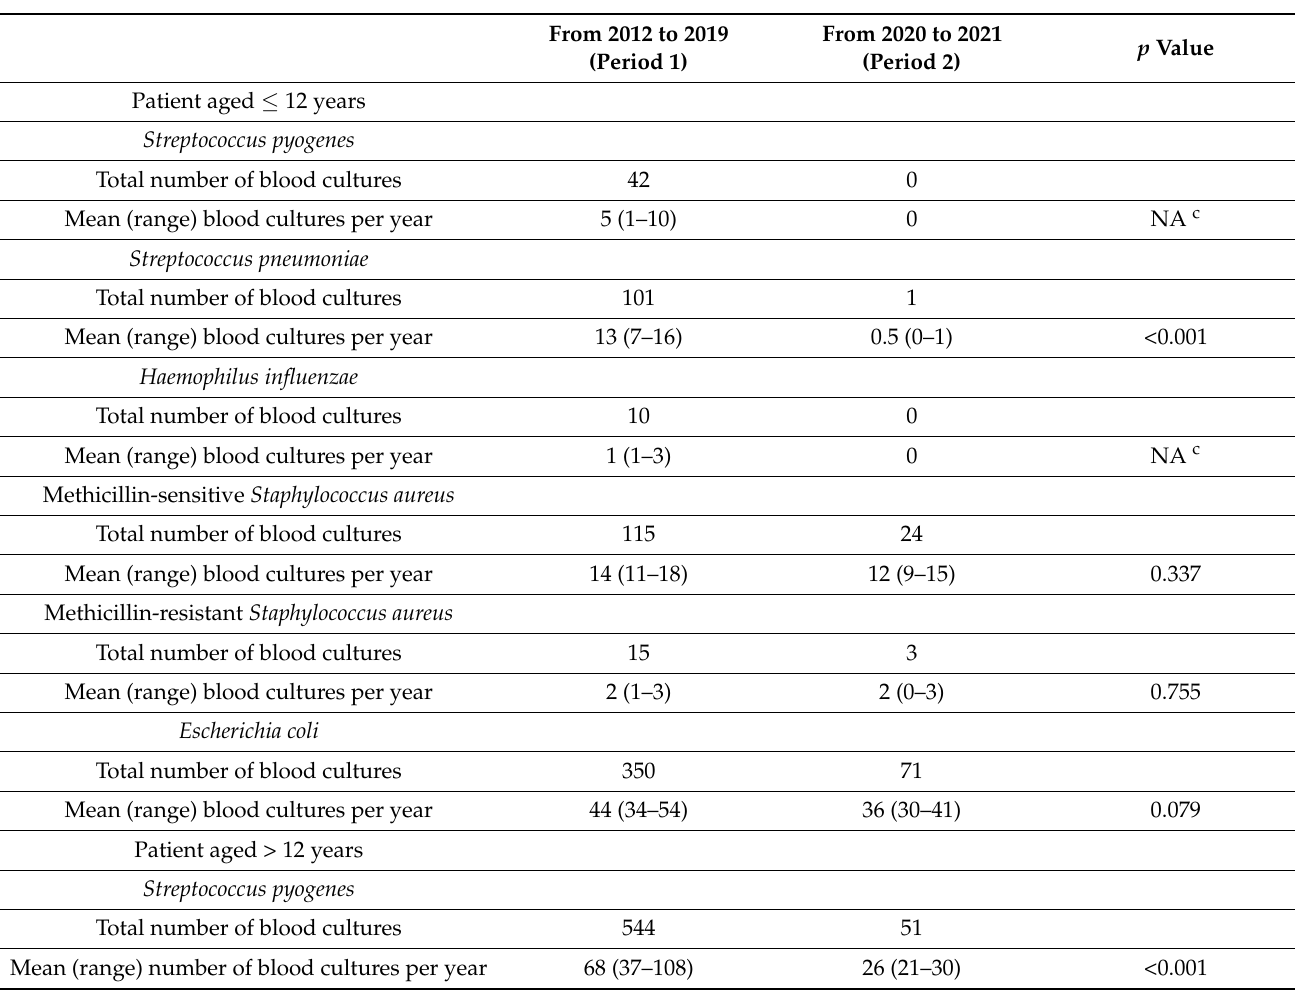
Table 2. Community-onset bacteremia of selected pathogens before and during the COVID-19 pandemic in Hong Kong according to age group a,b